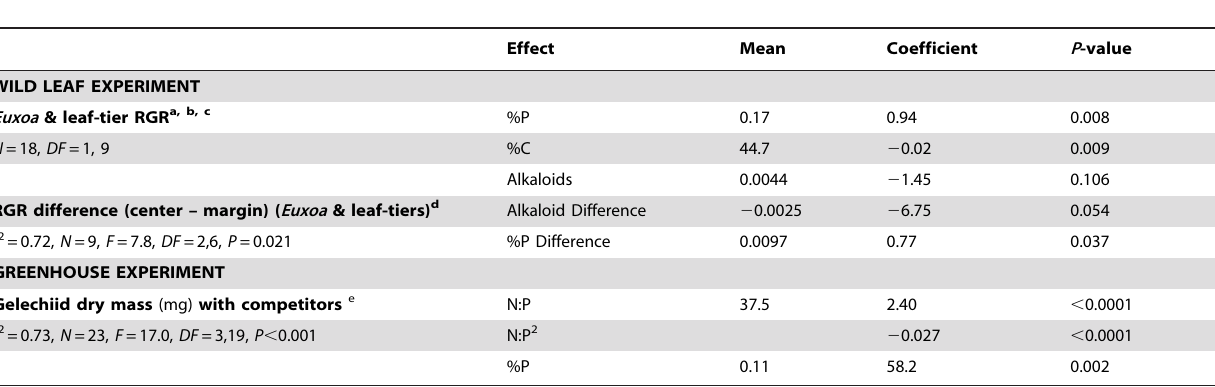
Table 1. Regression analysis of nutritional effects on herbivore RGR (d 2 1 ) or mass